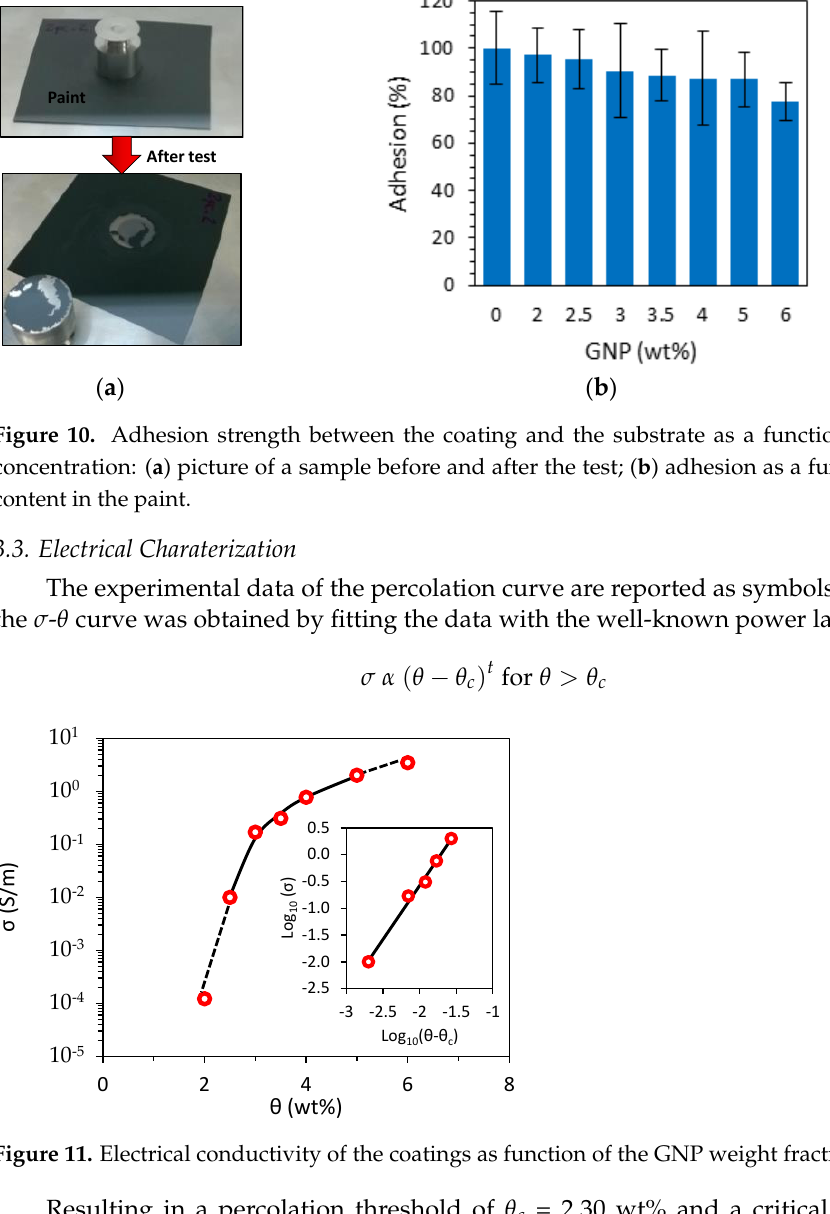
Figure 10. Adhesion strength between the coating and the substrate as a function of the GNP con- centration: ( a ) picture of a sample before and after the test; ( b ) adhesion as a function of GNP content in the paint.